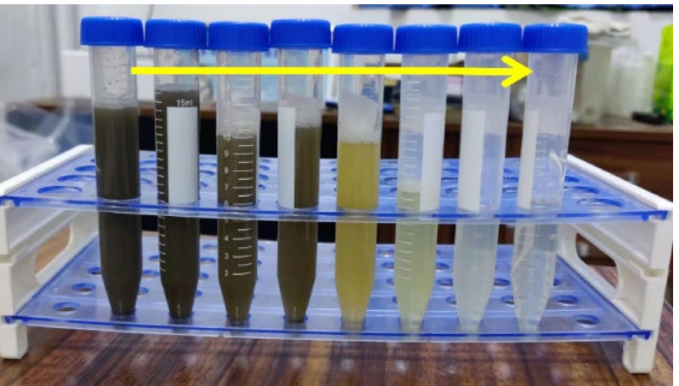
Figure 2. The apparent effect of EO on swine wastewater by Ti 4 O 7 anode at 50 mA/cm 2 current density (the solution from left to right is sample I with different treated time: 0 min, 5 min, 10 min, 15 min, 30 min, 60 min, 120 min and 180 min,